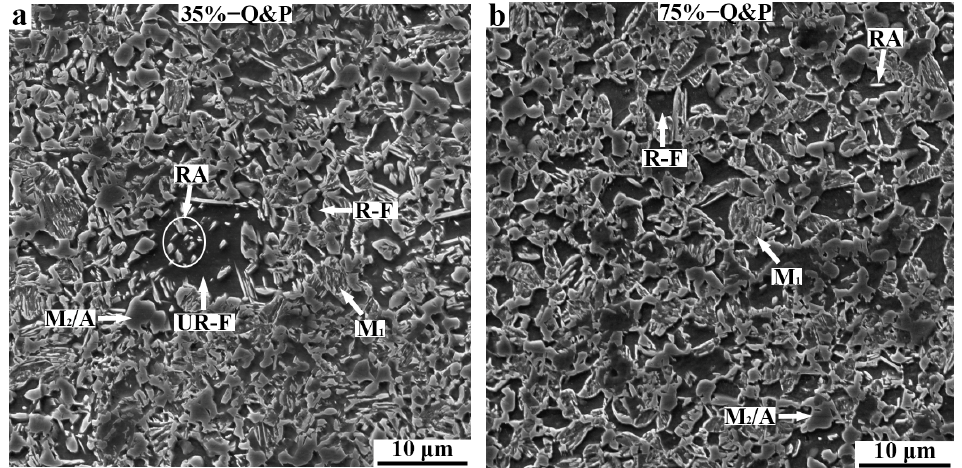
Figure 3. SEM micrographs of ( a ) 35%−Q&P sample and ( b ) 75%−Q&P sample. M 1 , M 2 /A, R−F, UR–F, and RA in figures refer to primary martensite, secondary martensite/retained austenite, re- crystallized ferrite, unrecrystallized ferrite, and retained austenite, respectively. The image−quality micrographs of the 35%−Q&P sample and 75%−Q&P sample an- alyzed by EBSD are shown in Figure 4. Austenite with a fcc crystal structure is highlighted in green. Ferrite and M 1 with a bcc crystal structure are in gray. The light gray refers to ferrite, and the dark gray represents M 1 . The dark region refers to M 2 for its high defect densities, and large quantities of substructures result in low image quality [17]. The results size of ferrite and retained austenite. The effects can be summarized in the following as- pects. Firstly, ferrite recrystallization occurred in the 35%−Q&P and 75%−Q&P samples; but, the grain size of the recrystallized ferrite in the 35%−Q&P sample was significantly smaller than that in the 75%−Q&P sample. Secondly, the contents of M 1 and M 2 in the 75%−Q&P sample were higher than those in the 35%−Q&P sample. Thirdly, abundant, small−size retained austenite and some large−size retained austenite coexisted in the 35%−Q&P sample, but the size of the retained austenite in the 75%−Q&P sample was more uniform (Figure 4a,b). The size distribution of the retained austenite in the 35%−Q&P sam- ple and the 75%−Q&P sample is shown in Figure 4c. The results indicate that the percent- ages of retained austenite with a size below 0.05 μm 2 and over 0.25 μm 2 in the 35%−Q&P sample were both higher than those in the 75%−Q&P sample. The average size of retained